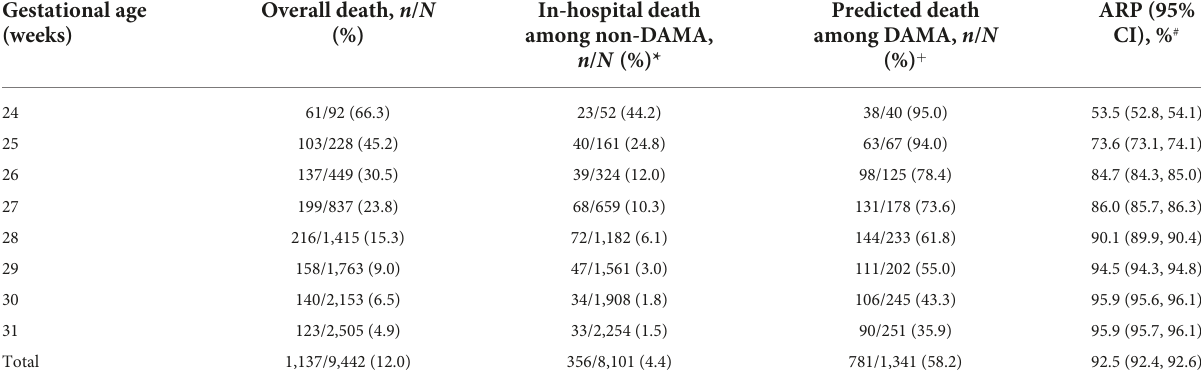
TABLE 4 Neonatal mortality of DAMA and non-DAMA infants born at 24 + 0 –31 + 6 weeks’ gestation in